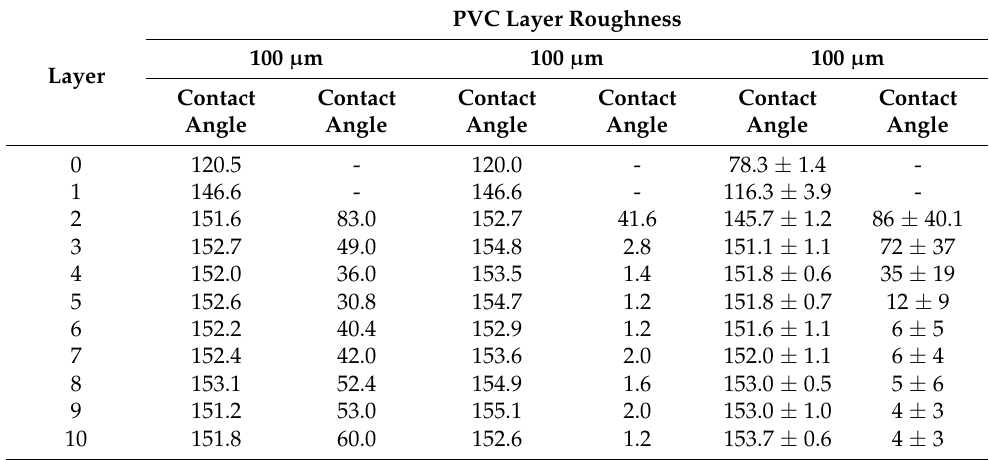
Table 4. Influence of roughness of the PVC layer on the hydrophobic properties of the coating.